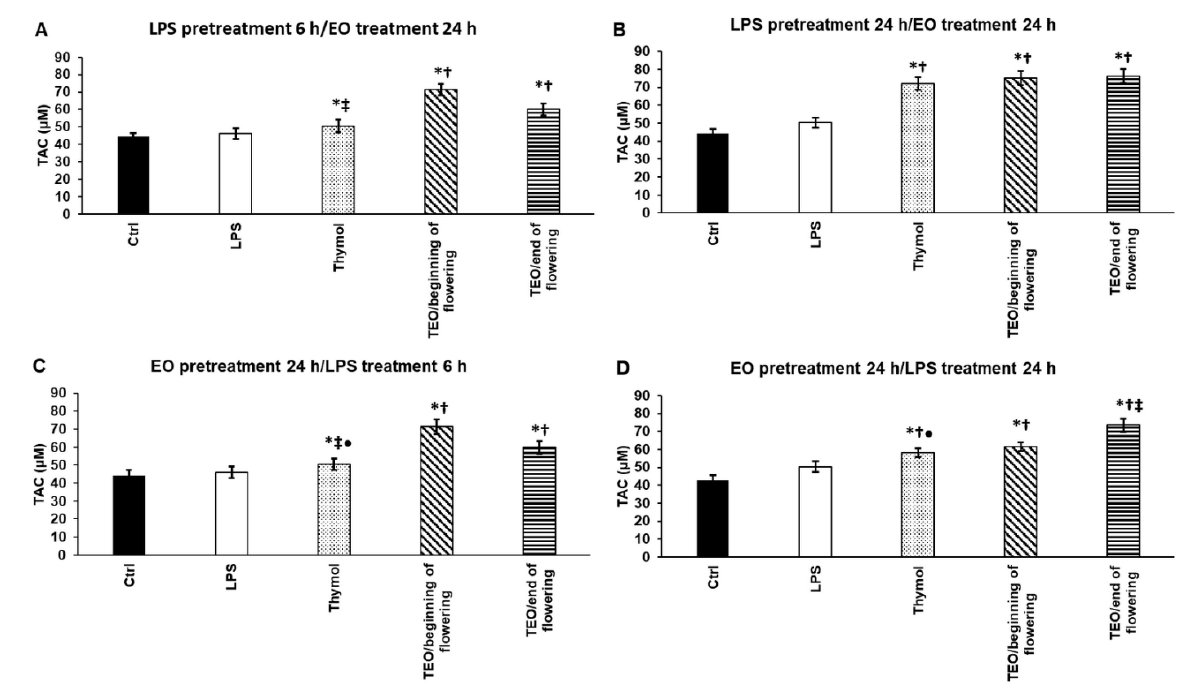
Figure 6. Determination of the effects of thymol and TEOs on total antioxidant capacity (TAC) of the THP-1 cells. As a control, the THP-1 cells were treated with DMSO, the carrier of EOs or distilled water, and the solvent of LPS in the same order and for the same time as in the case of the EO and LPS pretreatments. For LPS treatment, the cells were treated with LPS for 6 h or 24 h, and then they were treated with 500-fold diluted DMSO for 24 h, or they were treated with DMSO for 24 h, and then LPS was added for 6 h and 24 h. For LPS pretreatment, the cells were treated with LPS for 6 h and 24 h, and then they were treated using 500-fold diluted thymol or TEOs for 24 h. For EO pretreatment, the cells were treated with 500-fold diluted thymol or TEOs for 24 h followed by LPS treatments for 6 h and 24 h. TAC was determined using Antioxidant Assay Kit according to the protocol of the manufacturer and was expressed as μ M. The bars represent mean values, and error bars represent standard deviation (SD) for three independent experiments (n = 3). The assays were carried out in triplicate in each experiment. Asterisk indicates p < 0.05 compared to control. Cross marks p < 0.05 compared to LPS treatment. Double cross shows p < 0.05 compared to TEO/beginning of flowering. Bullet marks p < 0.05 compared to TEO/end of flowering. Statistical analysis was carried out by two-way ANOVA followed by Scheffe’s post hoc test.